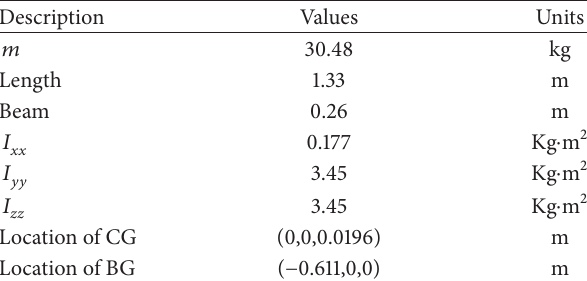
Table 1: Physical Parameters of REMUS